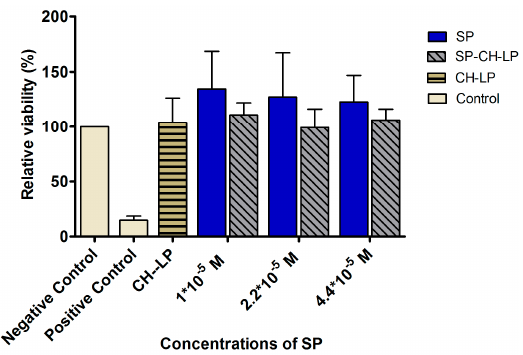
Figure 4. Effect of treatment with varying concentrations of free and liposome-encapsulated substance P on relative cell viability (metabolic competence) in HaCaT cells, as measured by MTT over 24 h (data represent the mean average ± standard deviation, n = 8). Triton X and cell culture media with supplements were used as positive and negative controls, respectively.